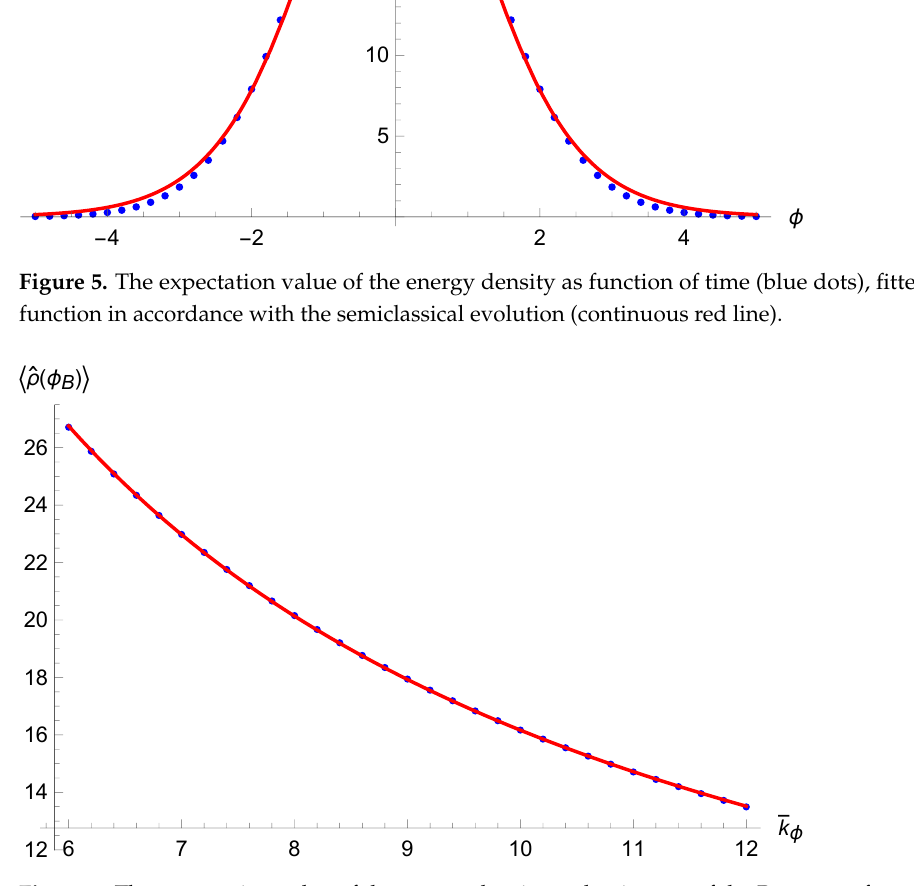
Figure 6. The expectation value of the energy density at the time φ B of the Bounce as function of k φ (blue dots), fitted with a function in accordance with the semiclassical evolution (continuous red